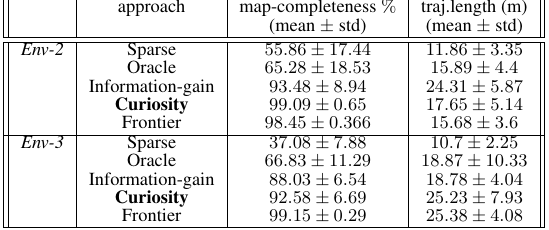
Table 1. Generalization results in the untrained environment Env-2 and Env-3